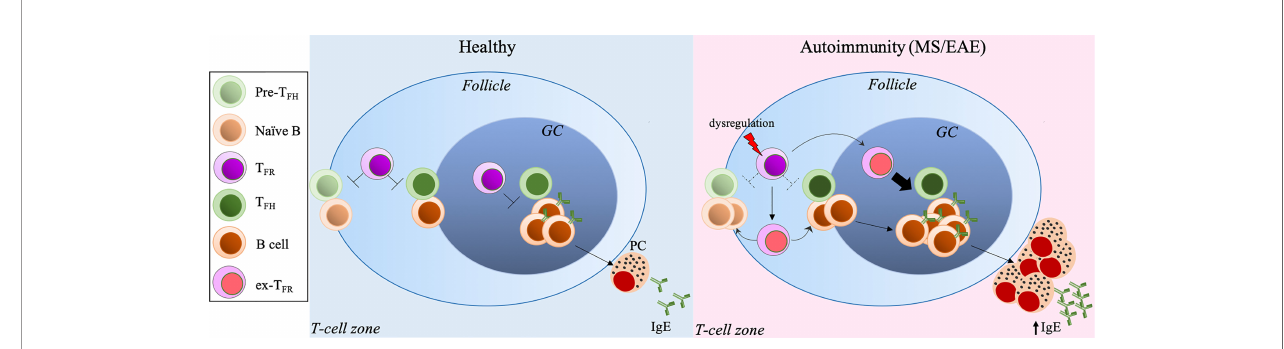
FIGURE 1 | Excessive T FH -GC-B cell response and IgE production secondary to dysregulated T FR cells exacerbate MS/EAE. Under normal conditions, IgE production is tightly controlled by the T FH -T FR cellular pair. Dysregulation of T FR cells leads to T FH /GC B-cell expansion and excessive IgE production, inducing autoreactive IgE, resulting in exacerbated autoimmune diseases, such as MS and EAE. PC, plasma cellse. x-T FR , desreguated T